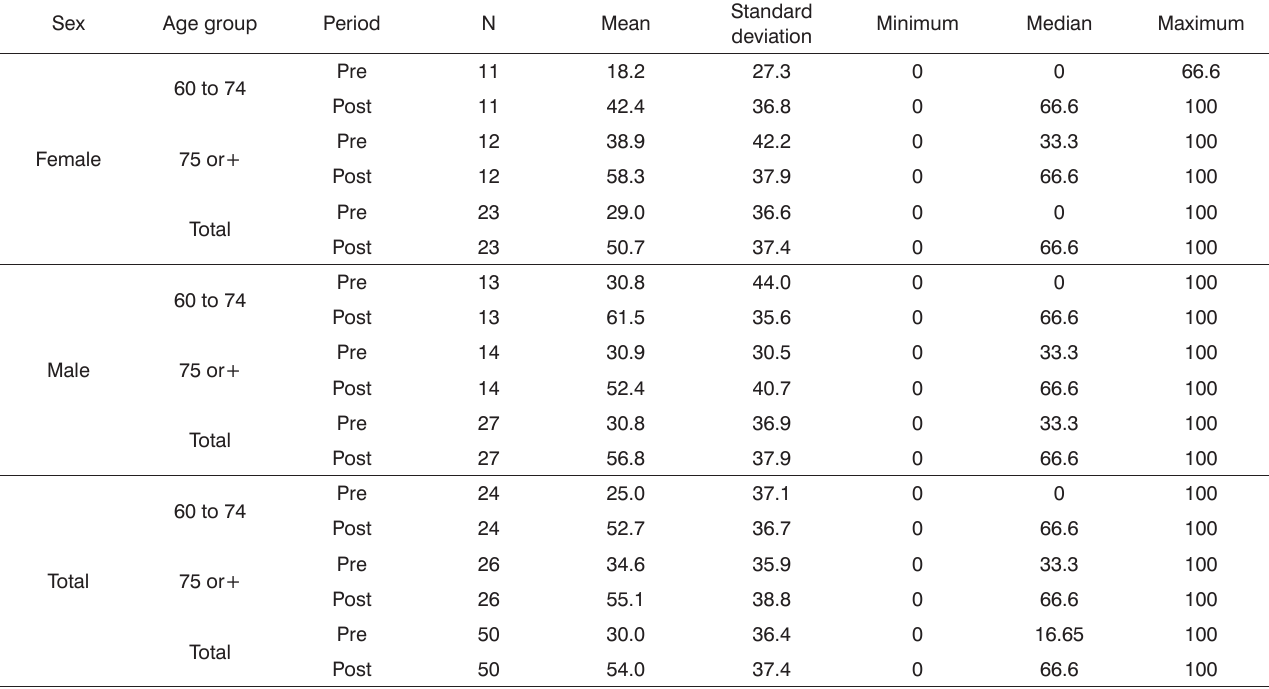
Analysis of variance Pre x Post → p = 0.000*